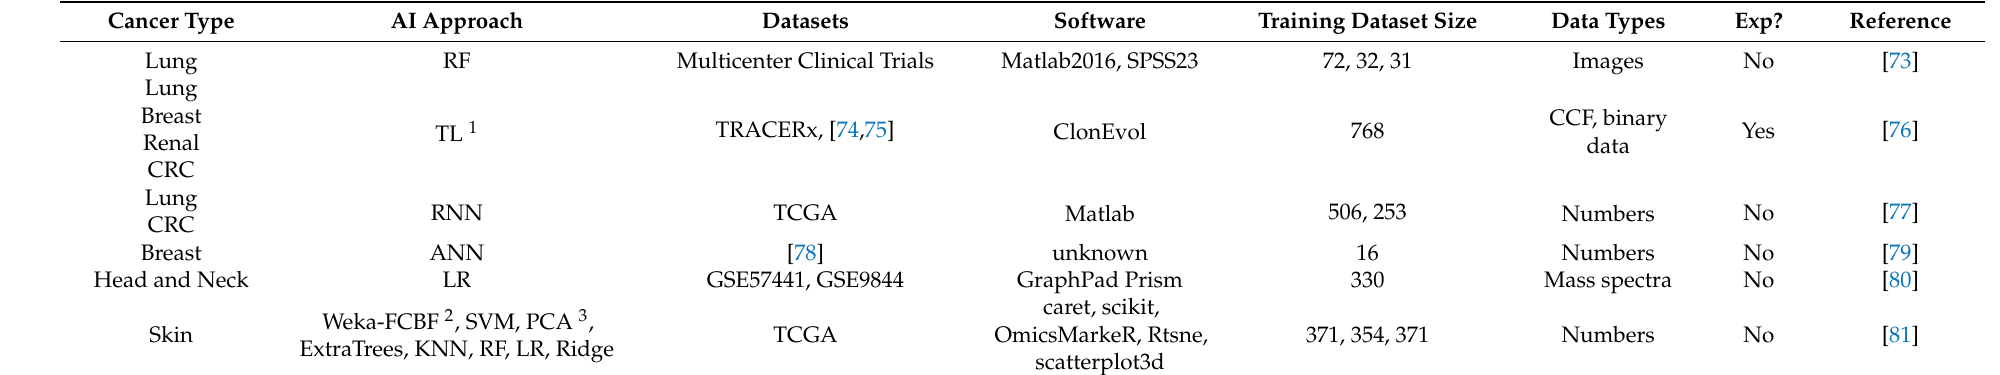
Table 3. Works applying ML to forecast cancer